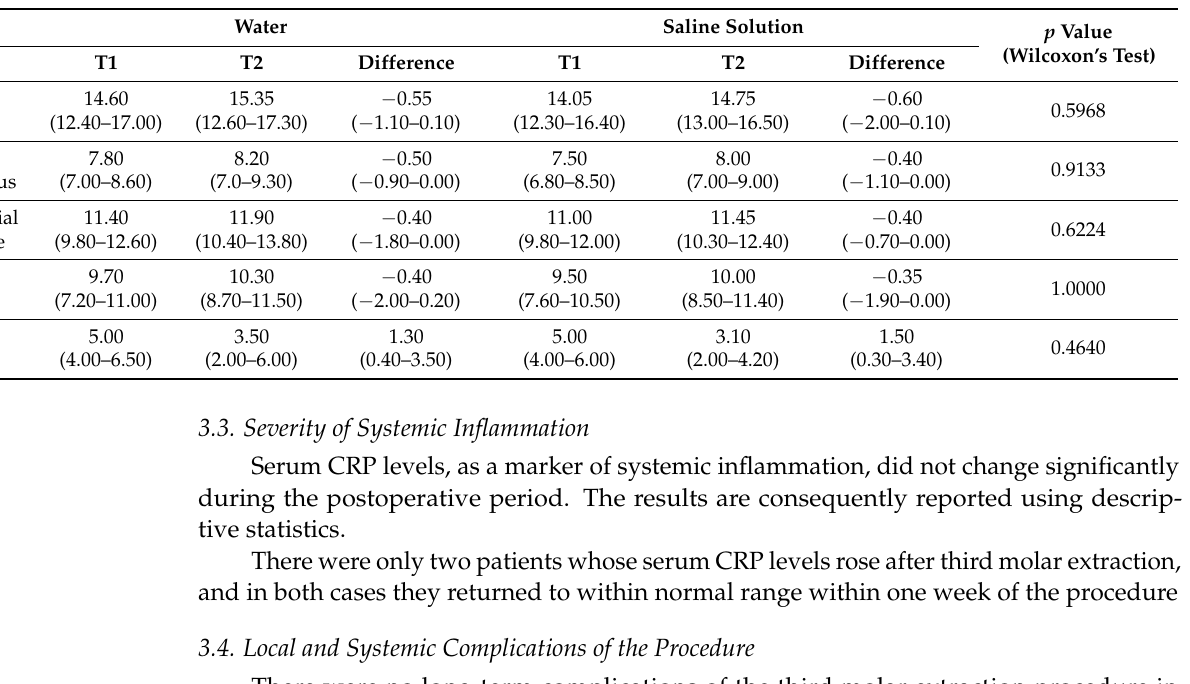
Table 2. Postoperative swelling measured in the two study